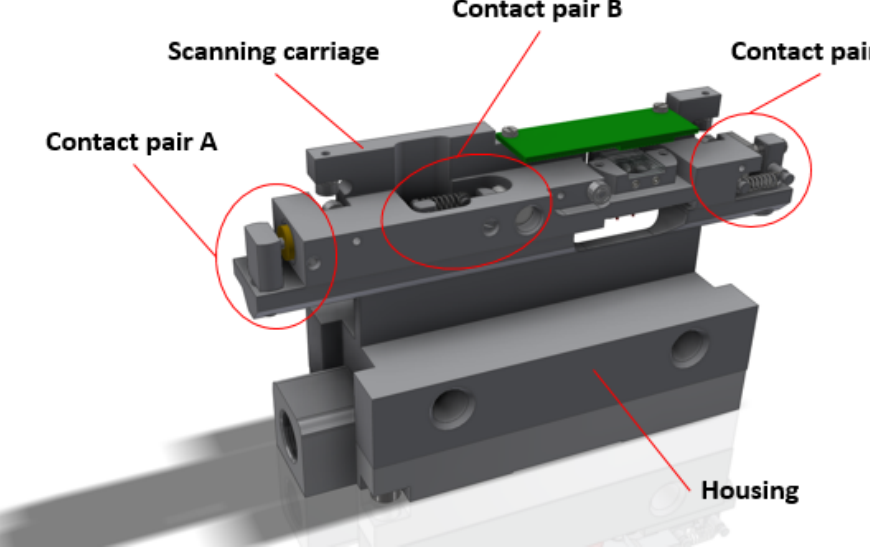
Figure 6. A 3D CAD model of the designed reading head with the marked contact pairs.